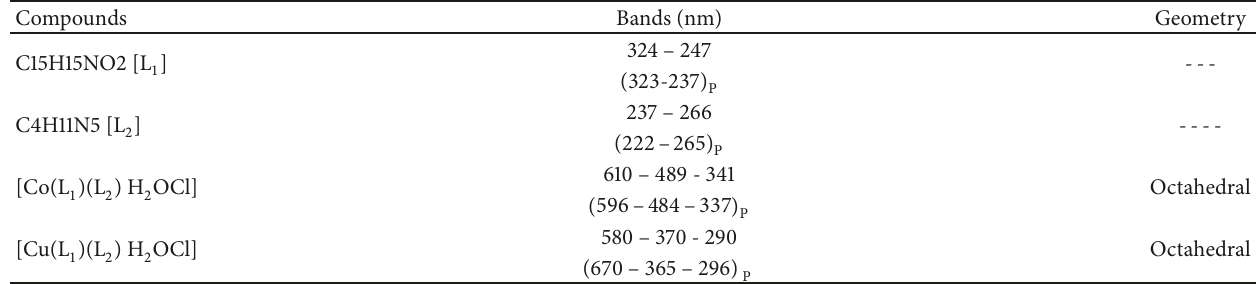
Figure 7: Effect of ligands and their complexes in the inhibition of different kinds of bacteria. Table 3: Experimental and theoretical UV-Vis spectrum bands of ligands and their